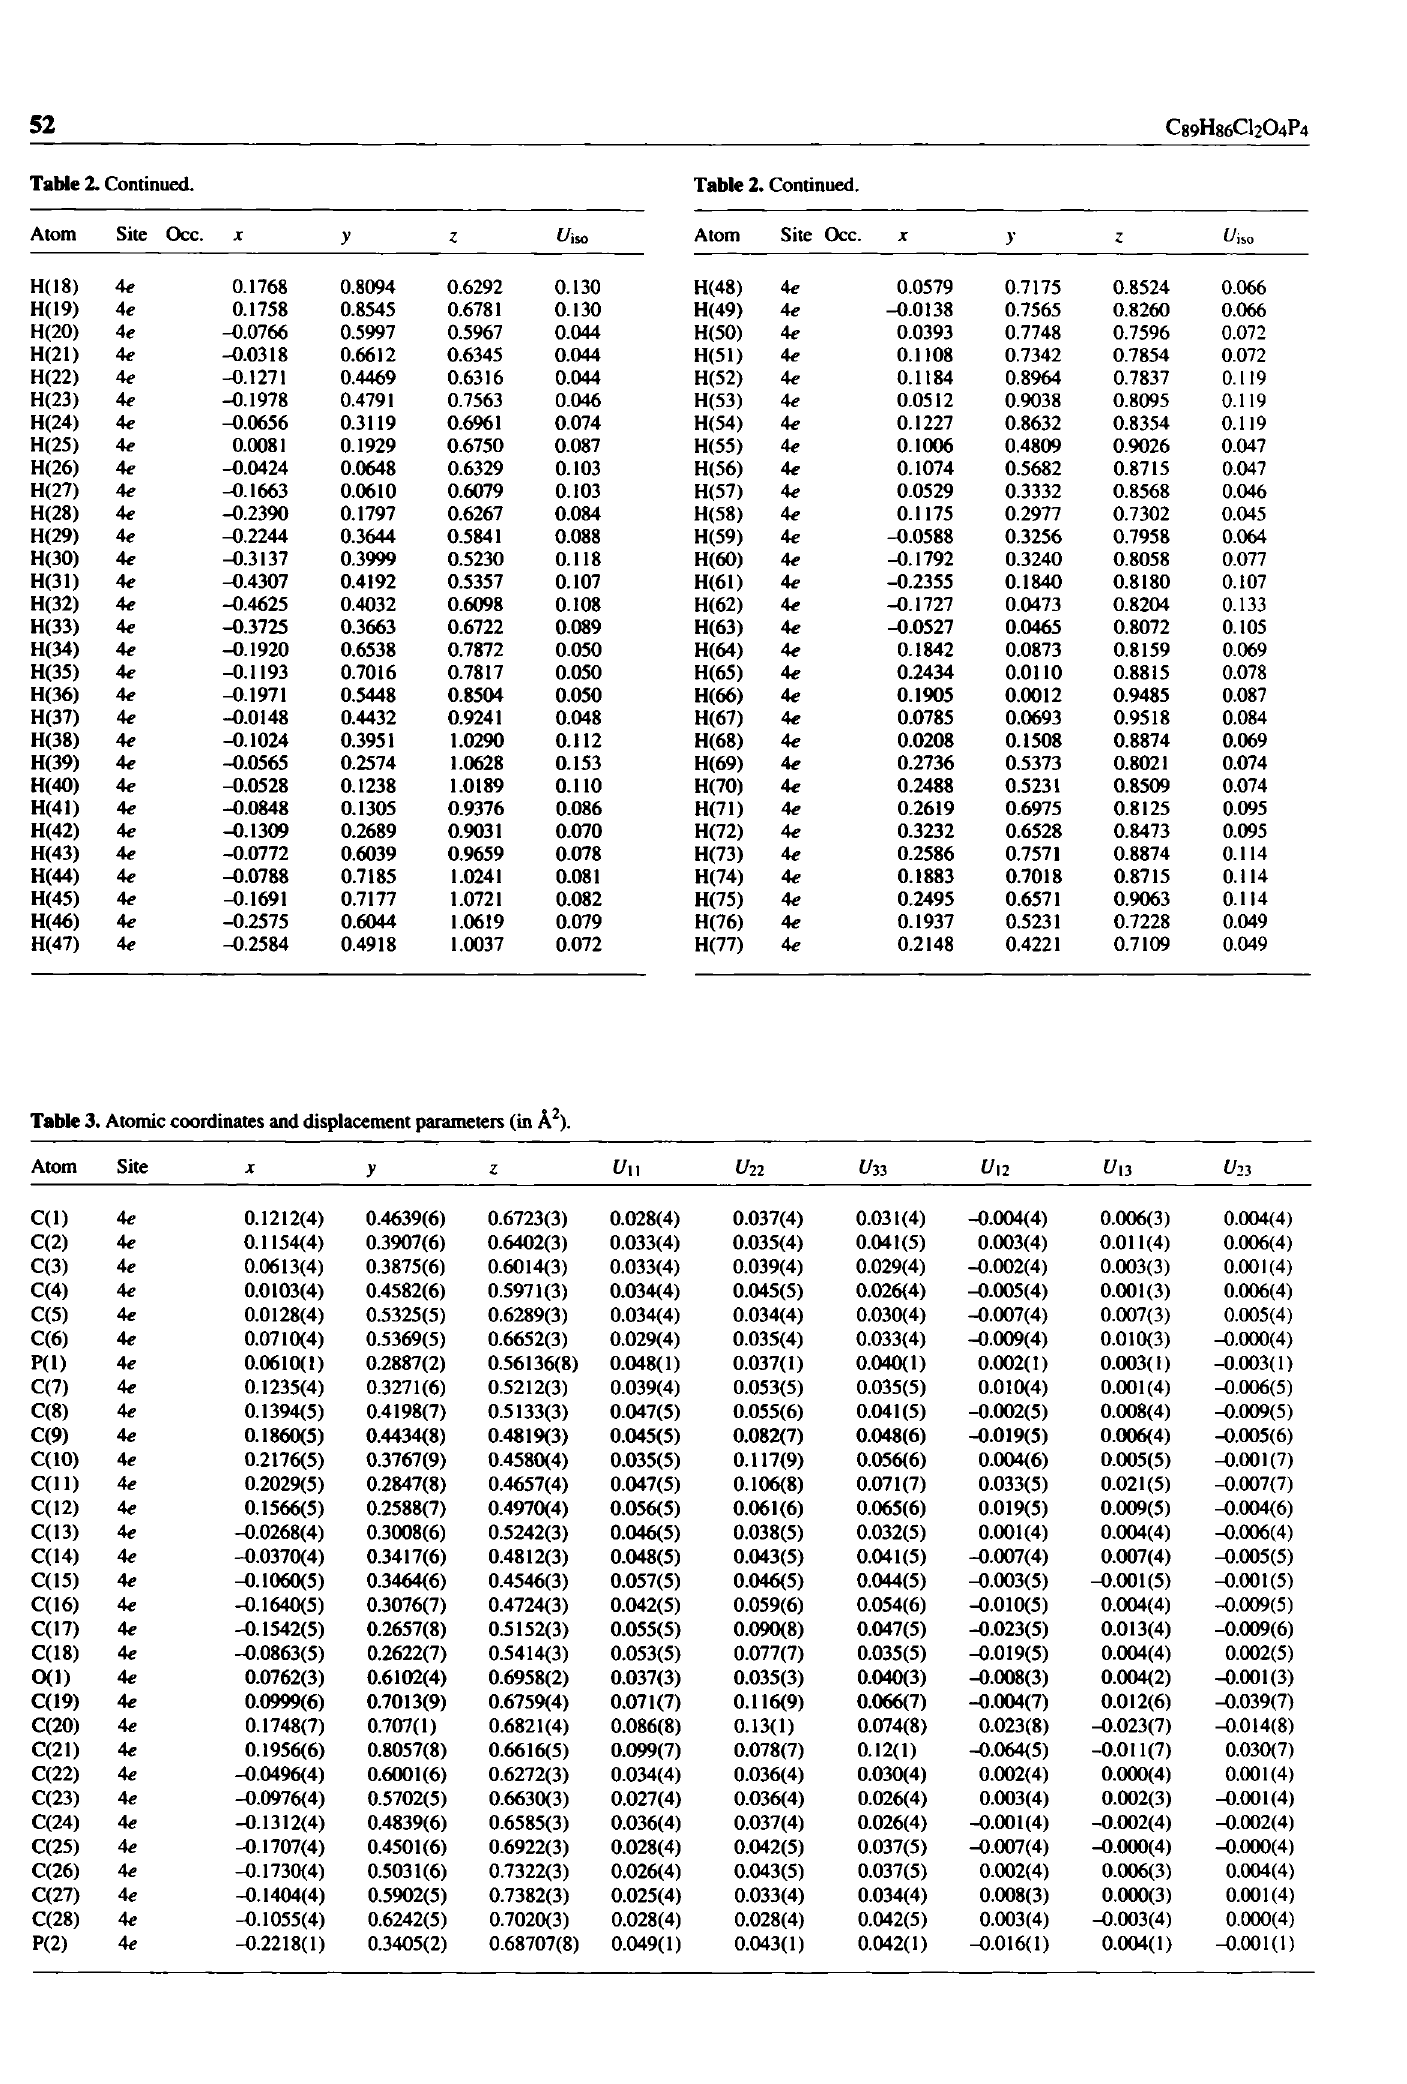
Table 3. Atomic coordinates and displacement parameters (in Â 2